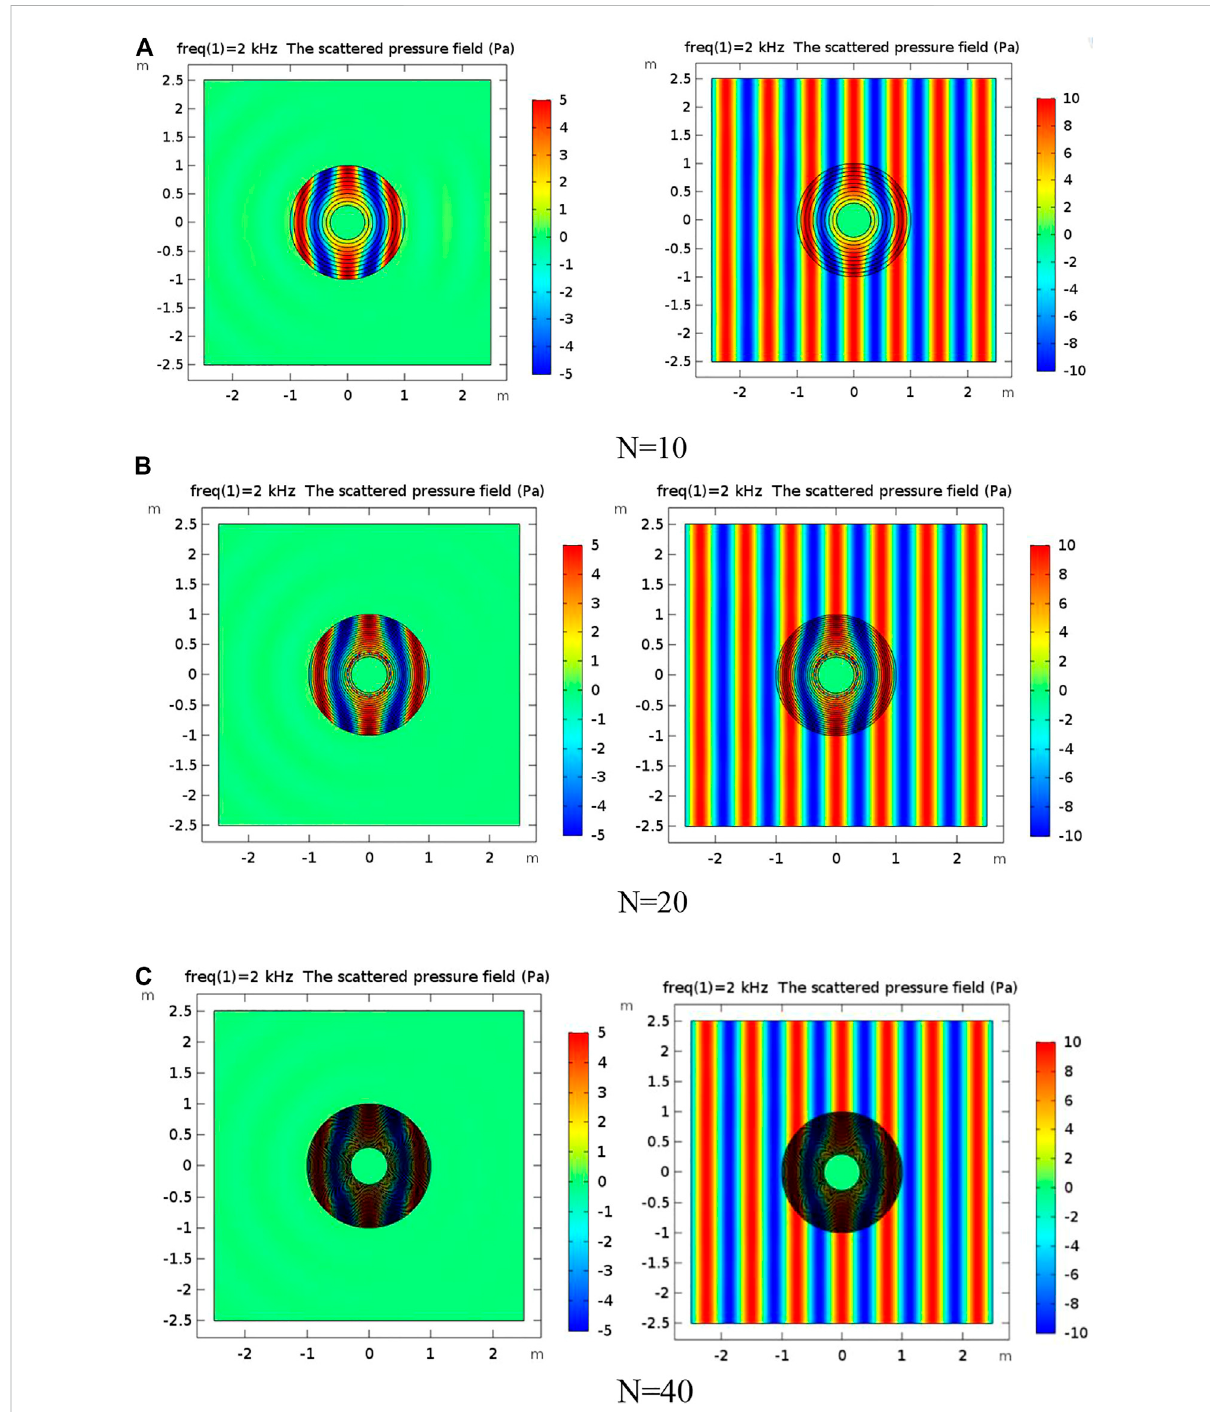
FIGURE 5 (A) Schematic diagram of sound fi eld when the number of acoustic cloak layers is 10 when the frequency is 2KHz. (B) Schematic diagram of sound fi eld when the number of acoustic cloak layers is 20 when the frequency is 2KHz. (C) Schematic diagram of sound fi eld when the number of acoustic cloak layers is 40 when the frequency is